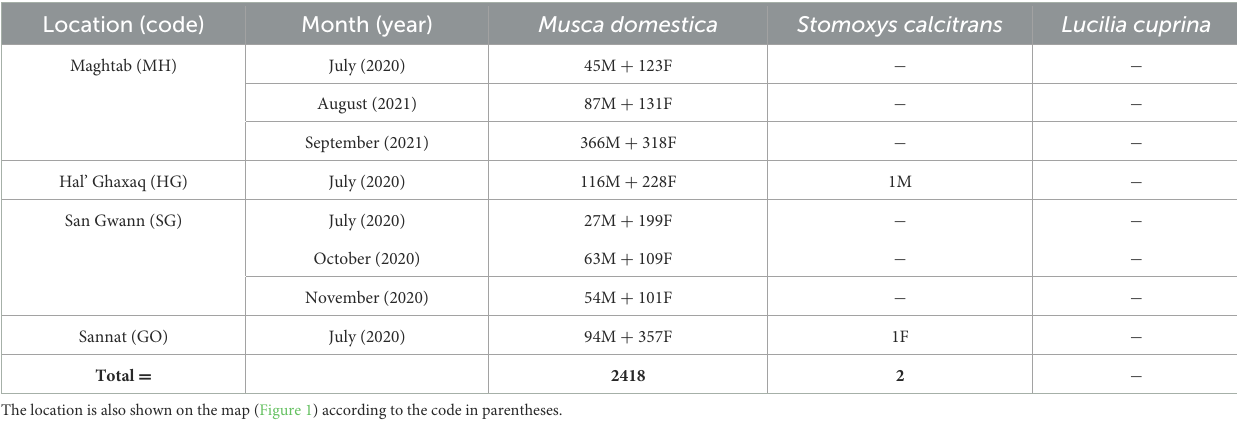
TABLE 1B Flies (M: males, F: females) collected near goats/sheep, pigs or dogs. Animals kept (code or